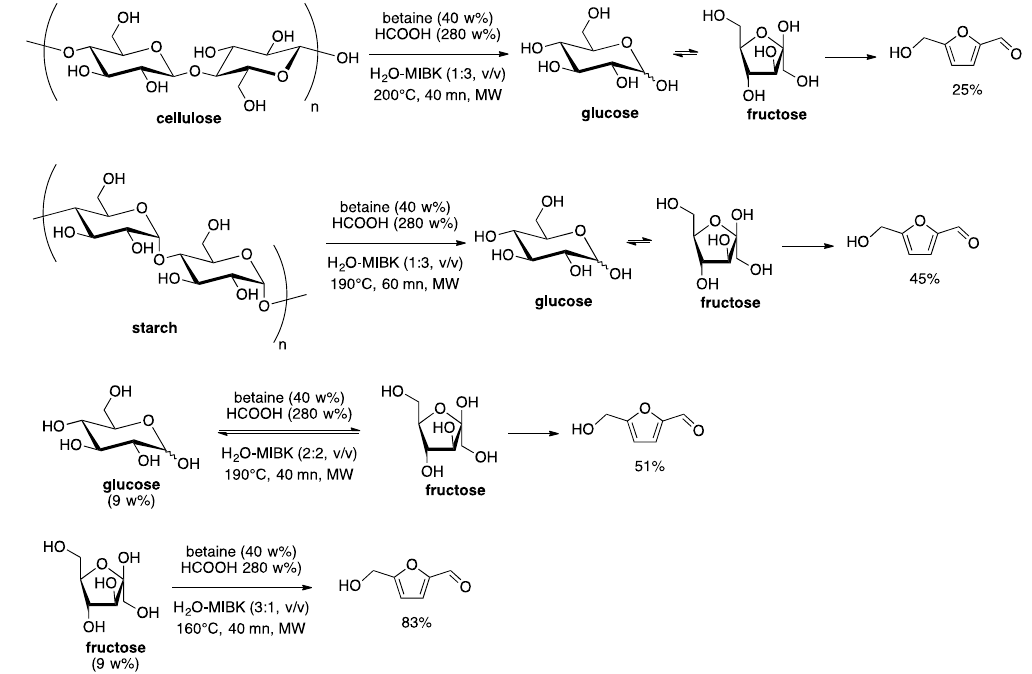
Scheme 8. Production of 5-HMF from glucose, fructose, microcrystalline cellulose, and starch